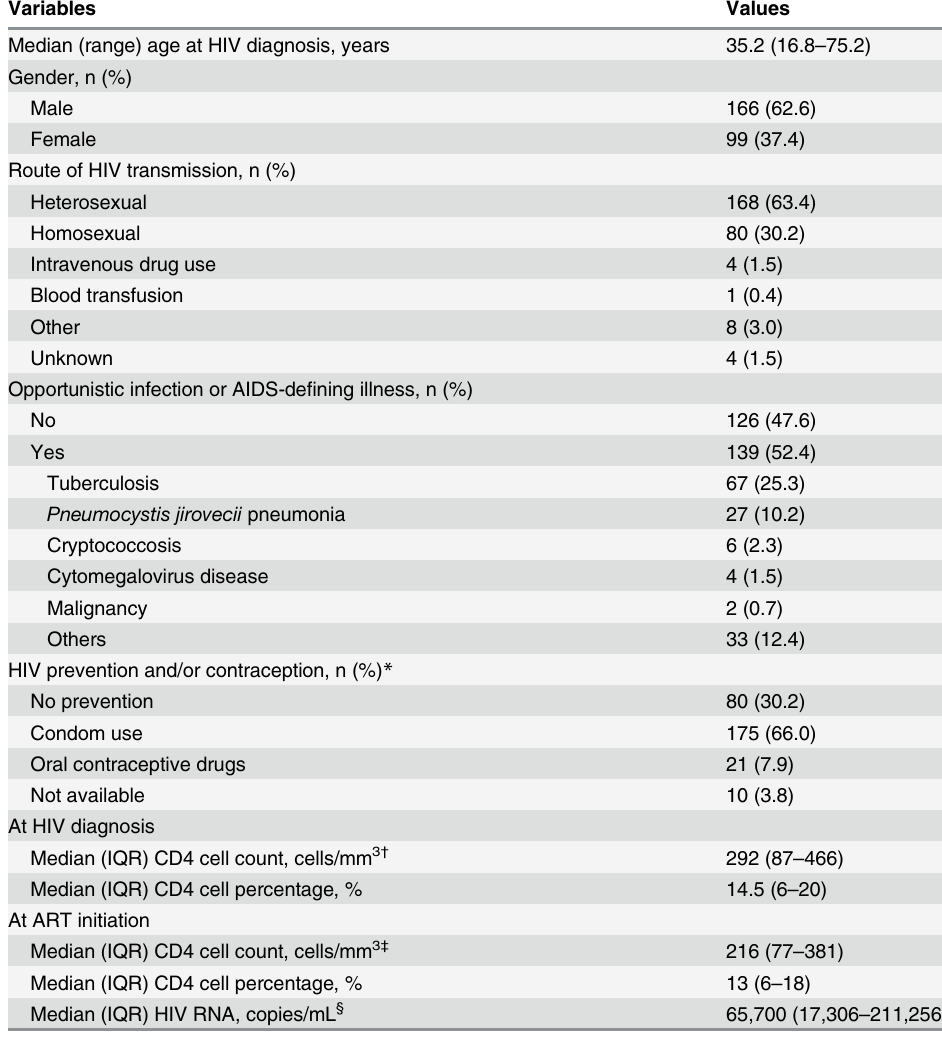
Table 1. Demographic and Baseline Characteristics of 265 Treatment-Na ï ve HIV-Infected Patients. Variables